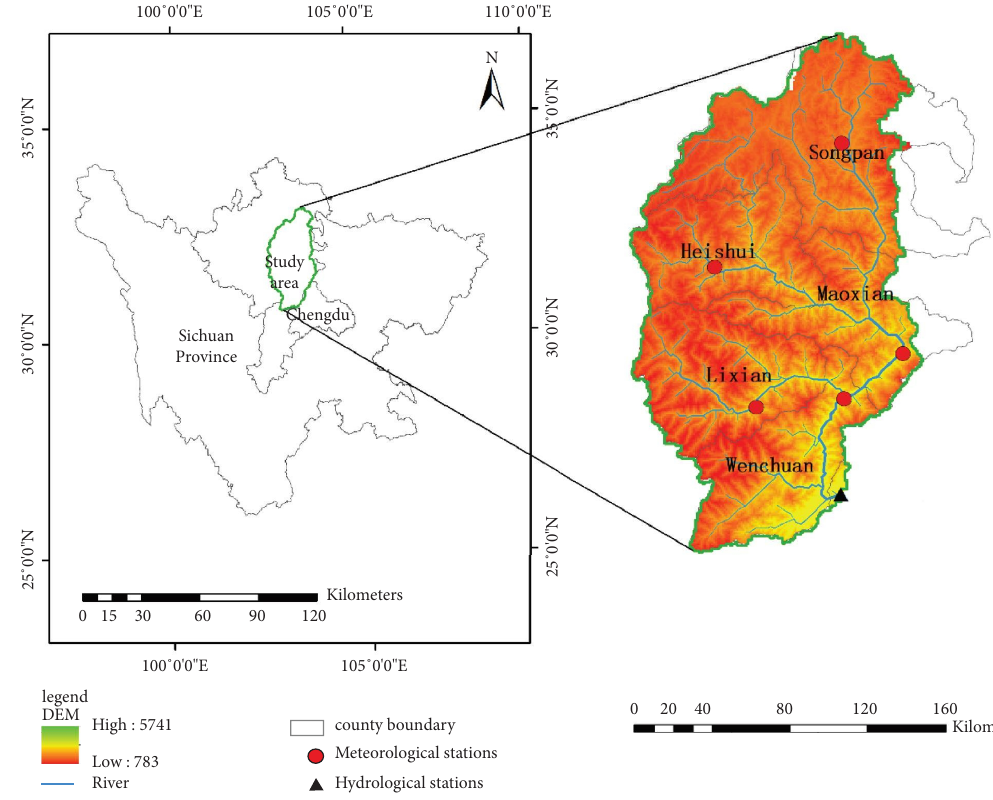
Figure 1: Te drainage system in the upper reaches of the Minjiang